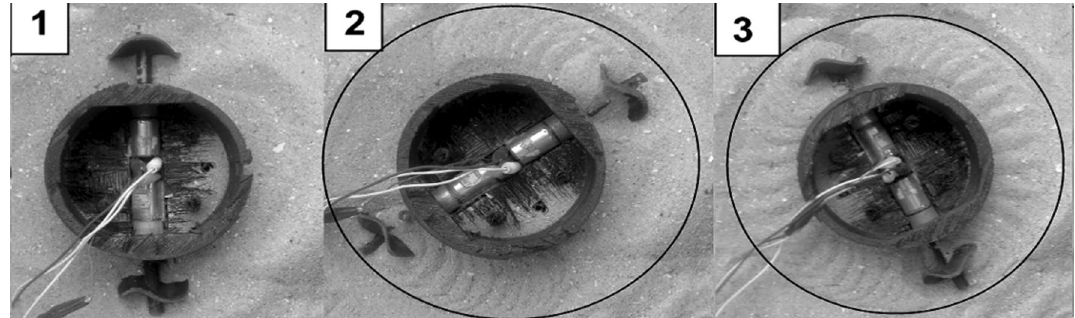
Figure 7. The two fabricated wheels platform through turning on the sand soil and the imprinted traces.